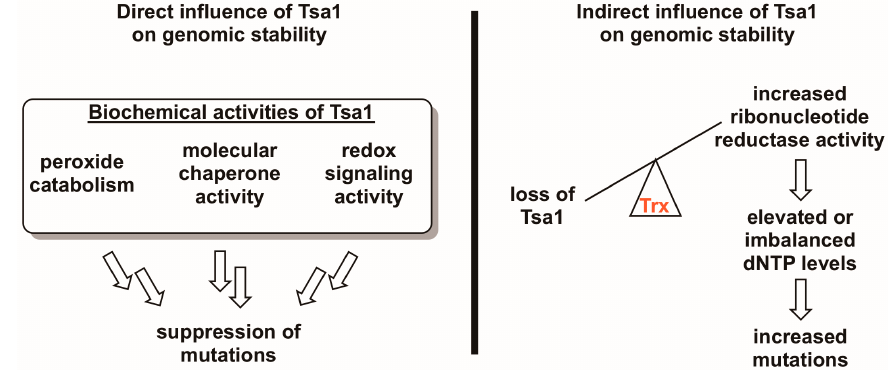
Figure 3. Tsa1 may influence mutation rates in a direct and/or an indirect way. Given the three biochemical activities of Tsa1 and related peroxiredoxins (i.e., peroxide detoxification, molecular chaperone activity, and redox switch activity), it is possible that any of these directly contribute to suppressing mutations. However, there is evidence suggesting that Tsa1 may influence genomic stability by titrating thioredoxin away from other substrates involved in DNA synthesis or repair, most notably ribonucleotide reductase. In the case of the Tsa1-ribonucleotide reductase competition hypothesis, Tsa1-mediated thioredoxin (Trx) sequestration may be a way of regulating ribonucleotide reductase activity, thereby maintaining appropriate dNTP levels and lowering mutation